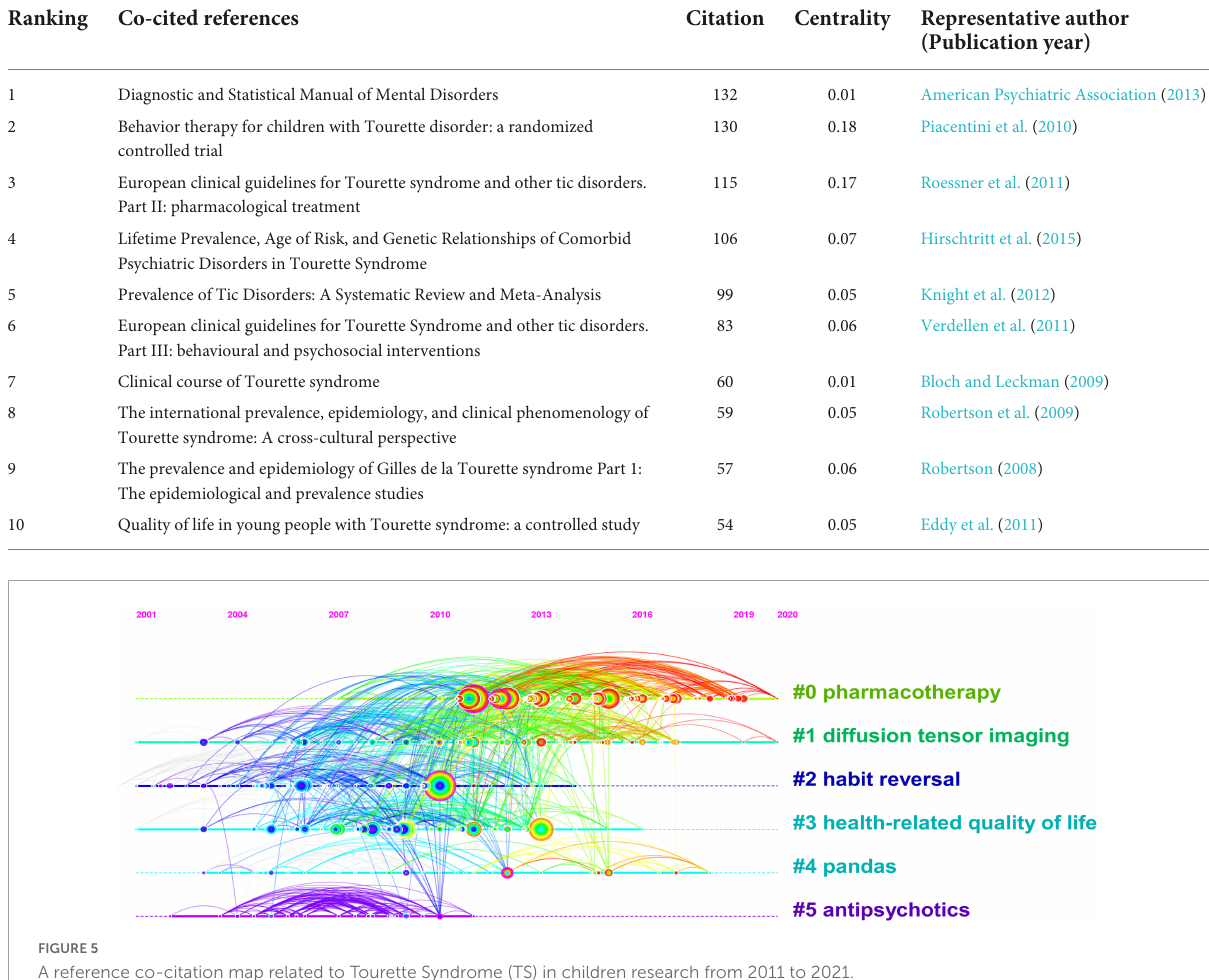
disorder, tic severity, symptom, schizophrenia, and